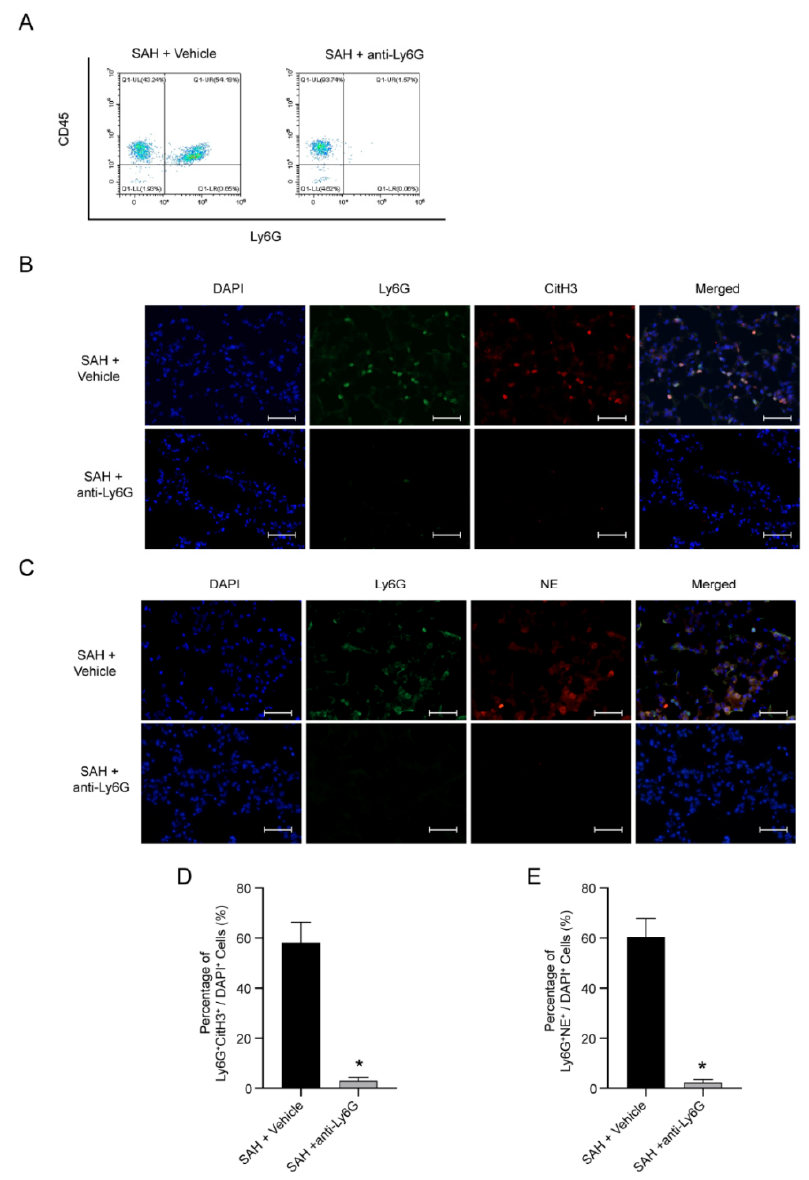
Figure 4. Ly6G depletion decreases the formation of NETs in NPE after SAH. ( A ) Representative flow cytometry analysis of the blood from SAH mice in different groups. ( B ) Representative photograph of the colocalization of CitH3 (red) with Ly6G (green) in different groups. The nuclei were stained with DAPI (blue). Scale bar = 50 μ m. ( C ) Representative photograph of the colocalization of NE (red) with Ly6G (green) in different groups. The nuclei were stained with DAPI (blue). Scale bar = 50 μ m. ( D ) Quantitative analysis of CitH3-positive neutrophils; n = 5/group. ( E ) Quantitative analysis of NE-positive neutrophils; n = 5/group. * p < 0.05 versus the SAH + vehicle group.